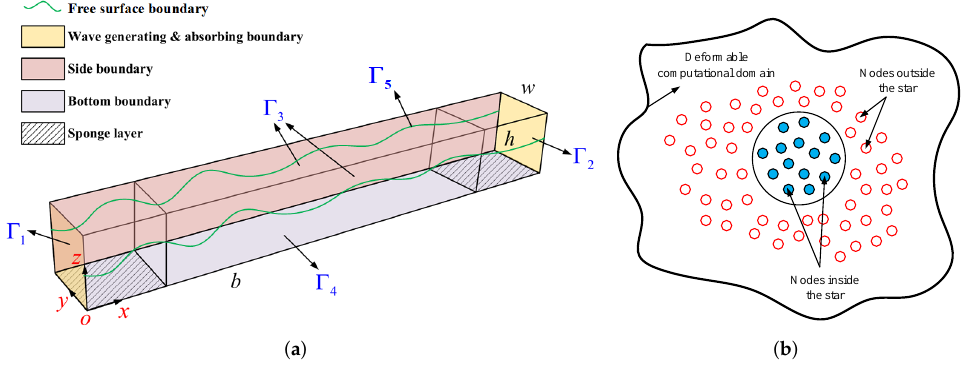
Figure 1. Schematic diagram of the developed 3D GFDM-based NWF. ( a ) Boundary conditions of the 3D GFDM-based NWF. ( b ) Nodes and the star in the